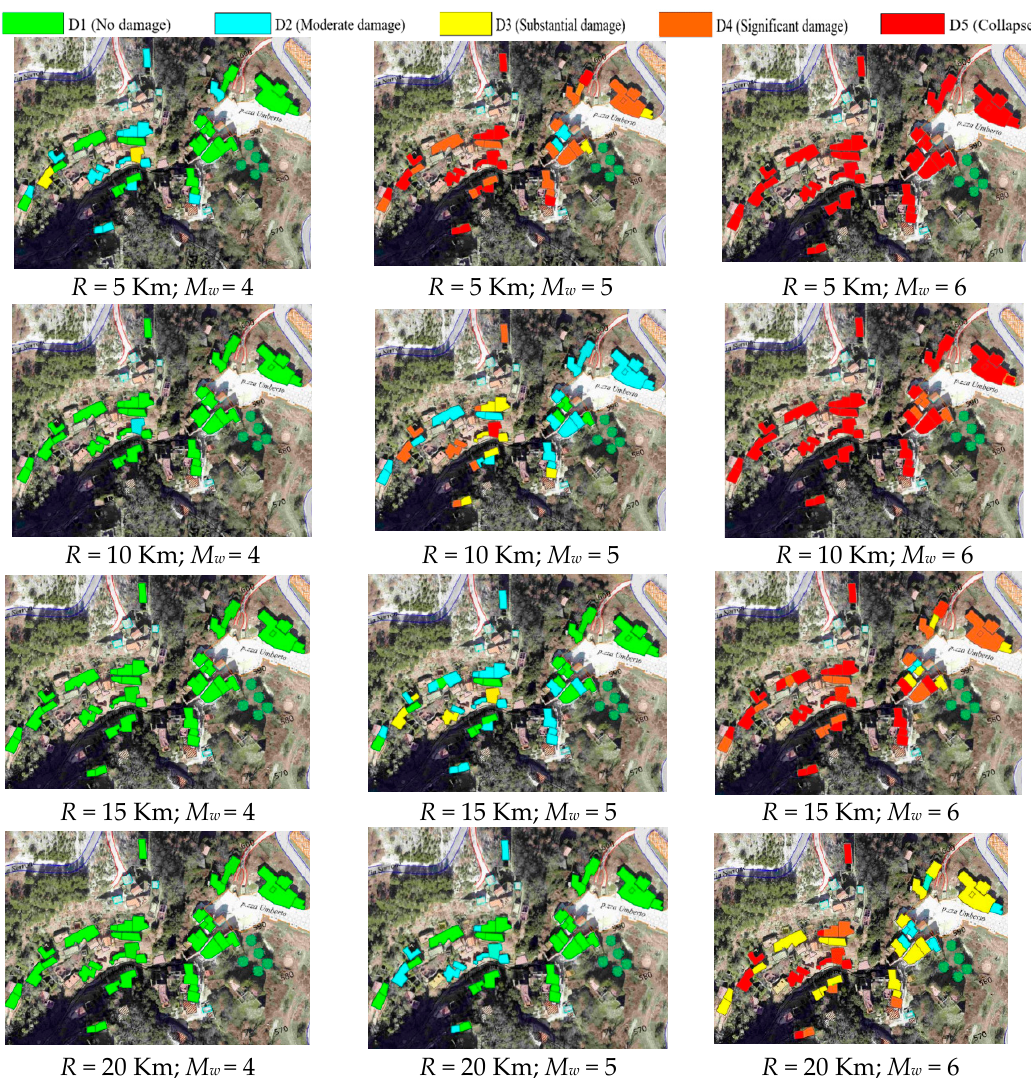
Figure 13. The new seismic damage scenarios considering the local amplification factor due to the geologic conditions.